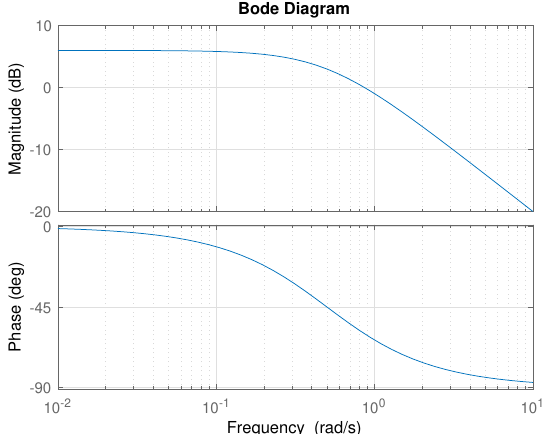
Figure 1. Example of a Bode diagram corresponding to an ordinary linear